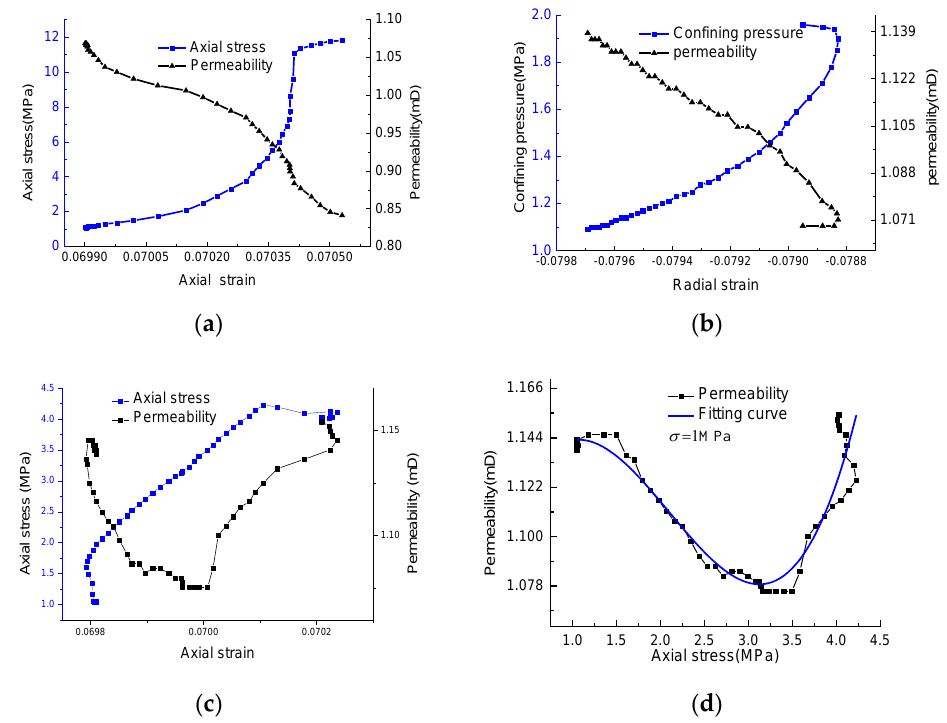
Figure 4. Experimental results of coal sample M1. ( a ) Unloading axial stress; ( b ) unloading confining pressure; ( c ) loading to secondary damage; ( d ) fitting curve of permeability and axial stress during the secondary damage period.